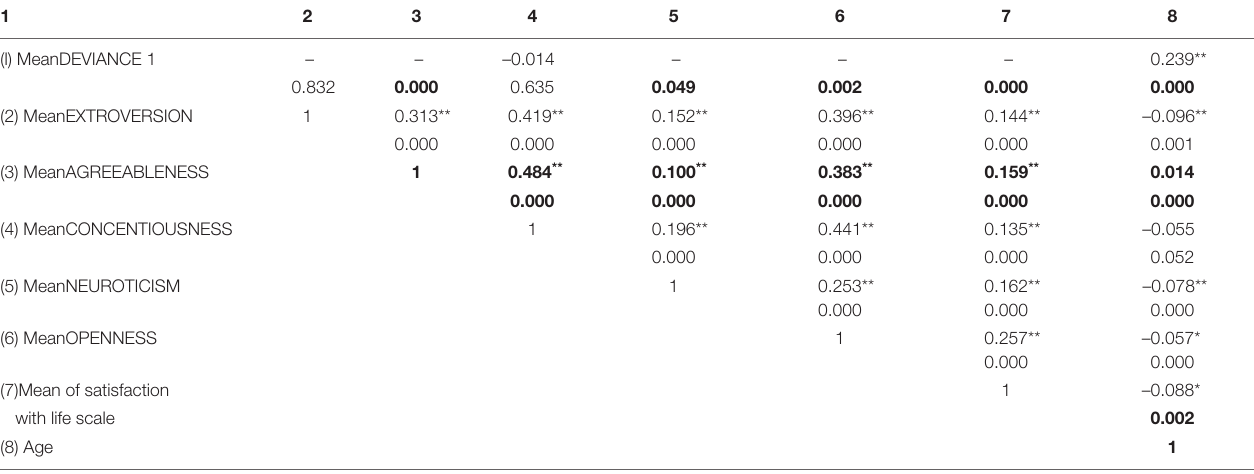
TABLE 5 | Relationship of deviant behavior to personality traits, family satisfaction and age.